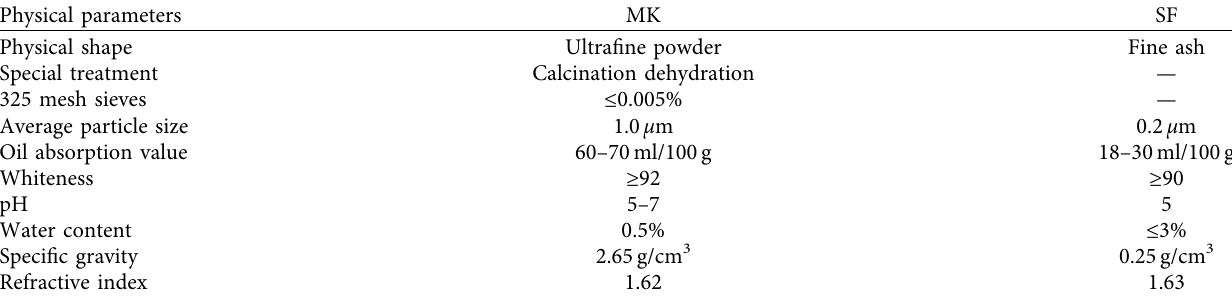
Table 3: Physical properties of MK and SF.